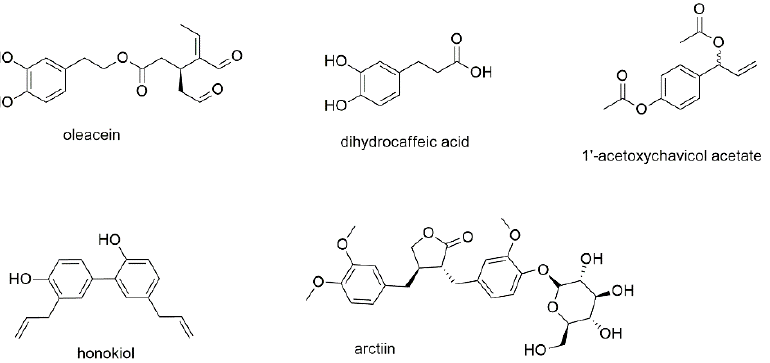
Figure 4. Phenylethanoids and phenylpropanoids with reported activity against myeloma cell lines.